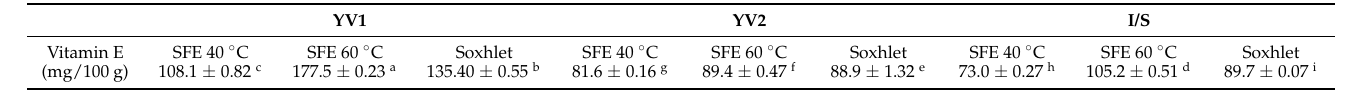
Table 3. Vitamin E ( γ -tocopherol) content in YV1, YV2, and I/S seeds oils extracted using SFE and Soxhlet.